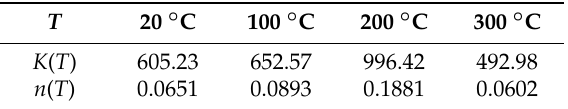
Table 2. Ramberg–Osgood equation parameters for the case of cyclic tension of the EN AW 2024T3 alloy at different temperature values [4].